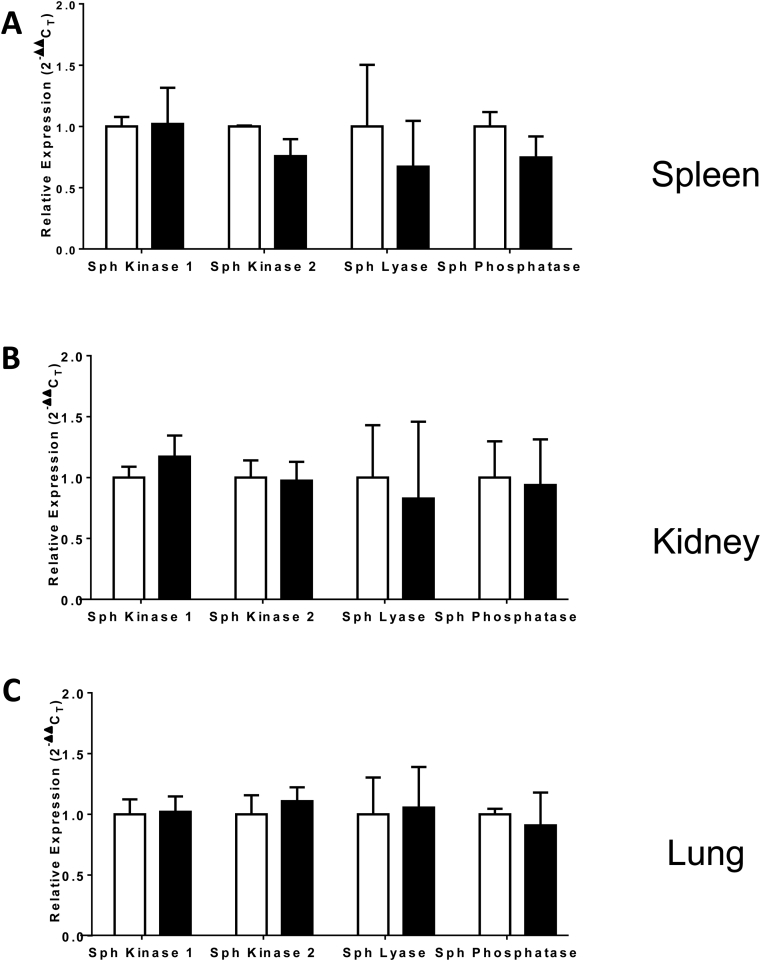
S1P gene expression in extrahepatic organs. Chronic liver injury was induced in age- and sex-matched C57/BL6 mice by twice-weekly intraperitoneal administration of carbon tetrachloride (1 mg/kg) in mineral oil for 8 weeks. Control mice received twice-weekly intraperitoneal injections of mineral oil. Mice were killed and gene expression of sphingosine kinase 1, sphingosine kinase 2, sphingosine lyase, and sphingosine phosphatase relative to glyceraldehyde-3-phosphate dehydrogenase was determined in (A) spleen, (B) kidney, and (C) lung. Bars represent means ± SEM fold change relative to control mice. N = 5 per group.